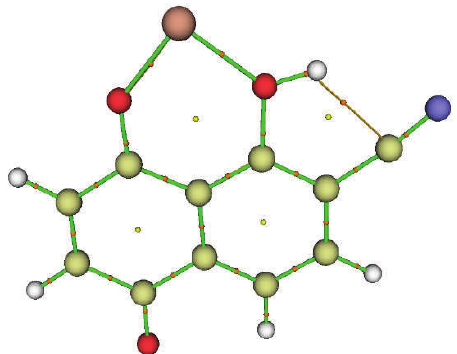
Figure 4: Molecular graph of 3A : bond critical points (small red spheres), ring critical points (small yellow sphere), bond paths (green lines), and O-H ⋅⋅⋅ CN VDW interaction (orange